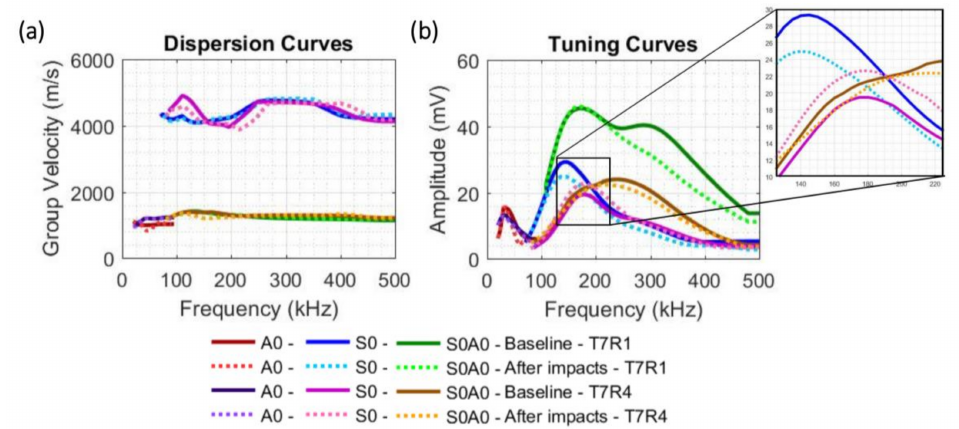
Figure 10. ( a ) Dispersion and ( b ) tuning curves comparison between the baseline and signals acquired after a 10J impact, for signals generated from transmitter ‘T7’ and received by receivers ‘R1’ (path on skin) and ‘R4’ (path on